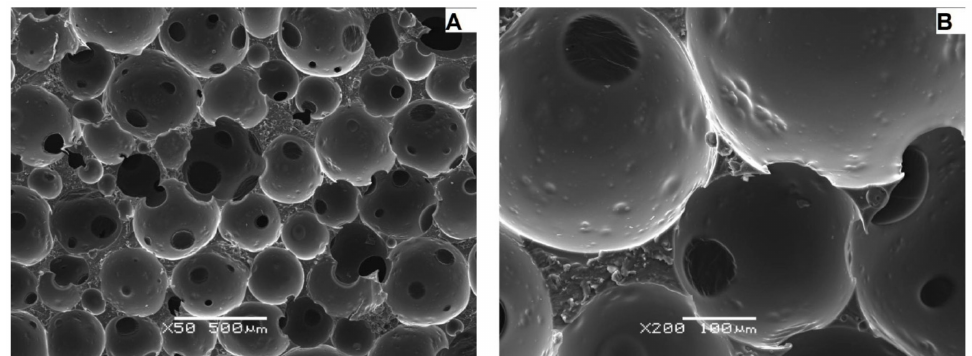
Figure 8. Micrographs of the carbon M1 sample taken with the use of SEM at various approximations: